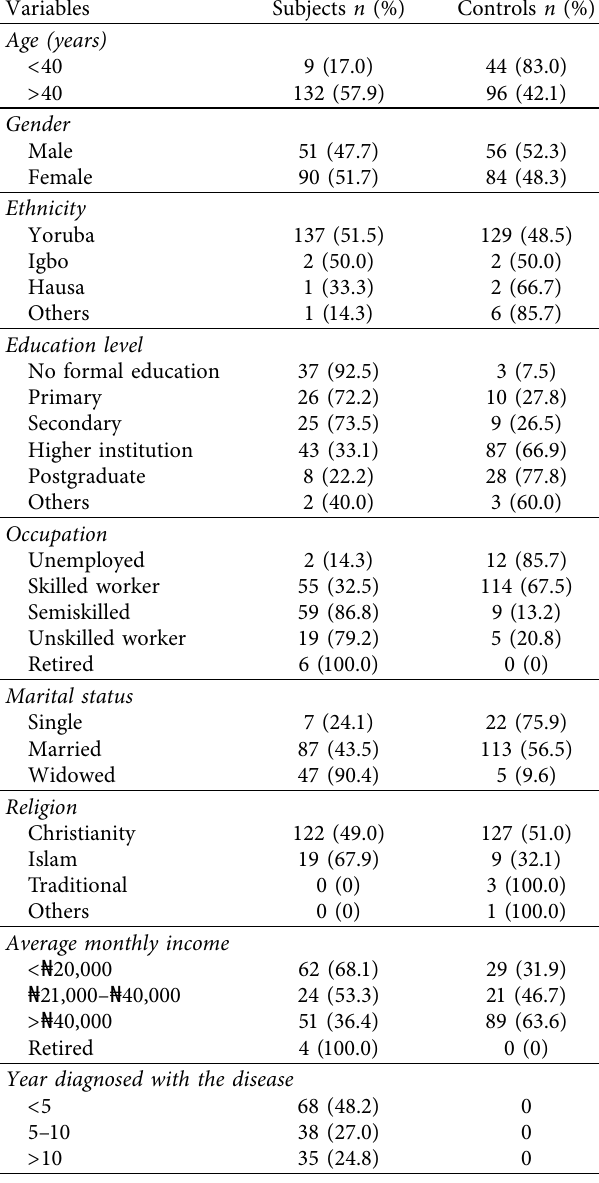
Table 1: Sociodemographic characteristics of diabetics and non- diabetics